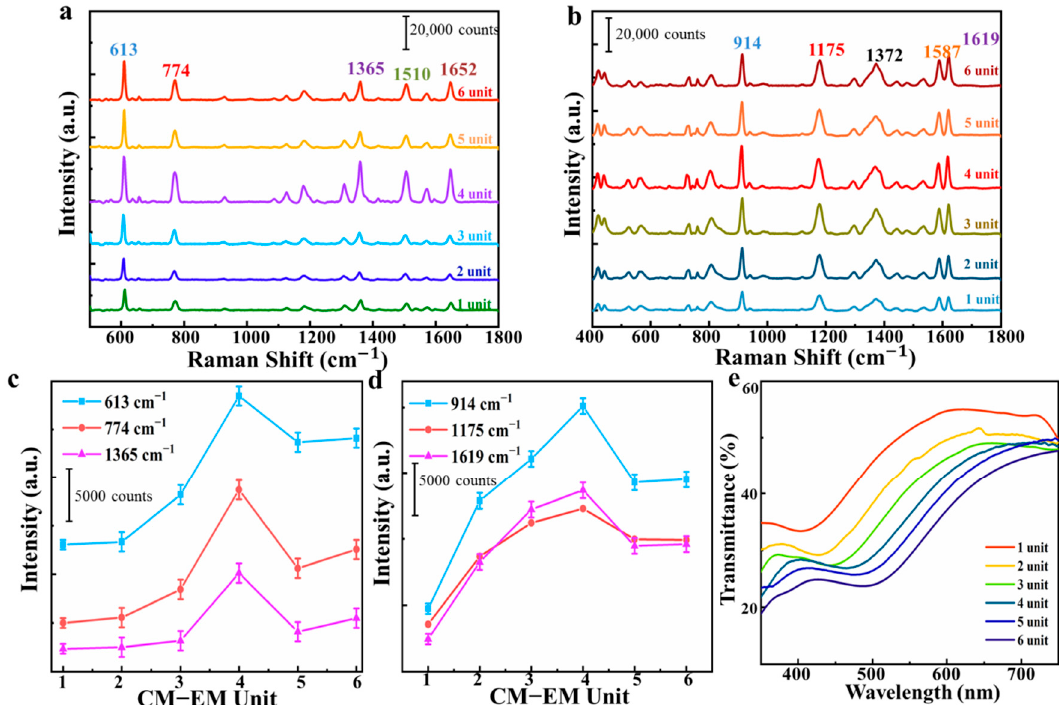
Figure 4. Raman spectra of ( a ) rhodamine 6G (R6G) with concentration of 10 − 6 M and ( b ) crystal violet (CV) with concentration of 10 − 5 M obtained from the multilayer substrate with various CM − EM units. Raman signal intensity of ( c ) R6G with concentration of 10 − 6 M at 613, 774, and 1365 cm − 1 peak, and ( d ) CV with concentration of 10 − 5 M at 914, 1175, and 1619 cm − 1 peak. ( e ) The transmittance of the substrate with different units.